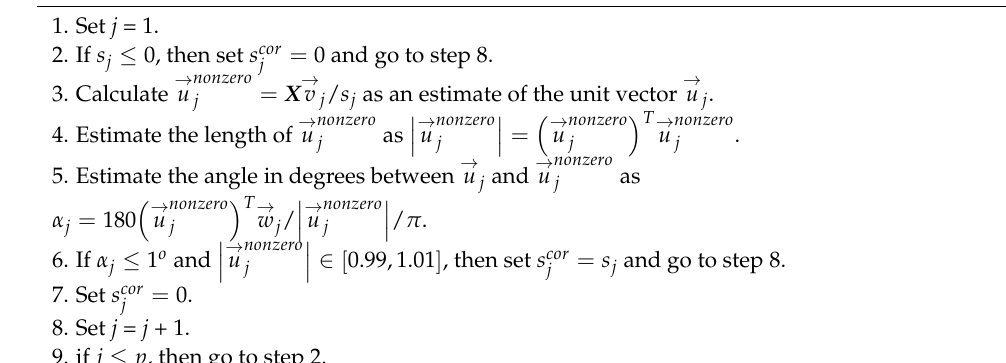
Algorithm 1: Classification and correction of singular values of a matrix